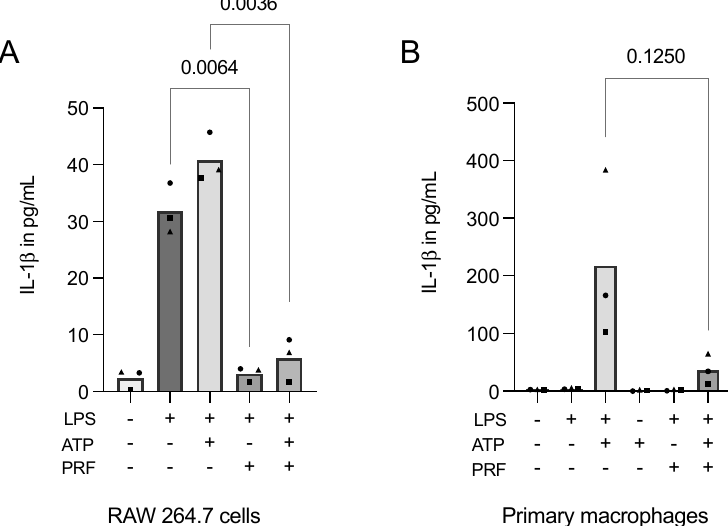
Figure 6. PRF reduces the secretion of IL-1 β in ATP-induced, LPS-primed RAW 264.7 cells ( A ) and primary macrophages ( B ). A reduction in IL-1 β following the introduction of PRF in RAW 264.7 cells and primary macrophages that were stimulated with LPS and received a second signal from ATP was reported. Each data point represents an independent experiment. n = 3. To compare groups, individually paired t -tests were applied.